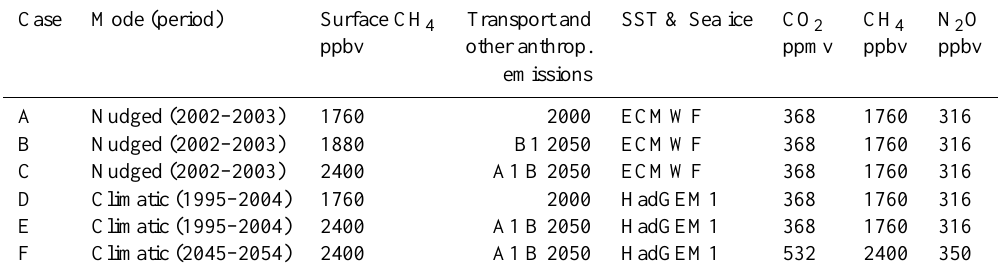
Table 2. Set-up of the LMDz-INCA modelling experiments. The A to C experiments correspond to nudged simulations (2002–2003, ECMWF meteorology) and the D to F experiments to 10-yrs climatic simulations (GCM mode). For each of these runs, “perturbation” runs have been performed, by applying a 5% emission reduction to each of the three transport modes separately (Cases A to C) and/or simultaneously (Cases D to F). The first and the first three years have been discarded as the spin-up of the model, for nudged and climatic runs,